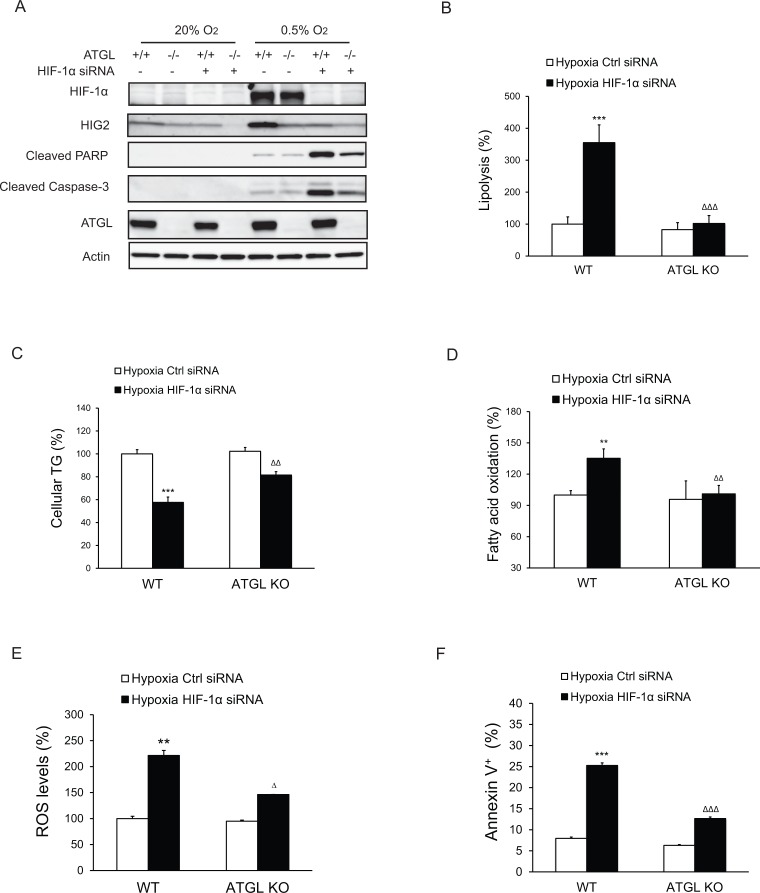
Apoptosis induced by HIF-1α knockdown is lipolysis-dependent.HCT116 WT or ATGL KO clone cells were transfected with control siRNA or HIF-1α specific siRNA for 24 hr, followed by incubation under normoxia or hypoxia for indicated times. (A) Cell apoptosis was detected by immunoblotting after 48 hr of incubation under normoxia or hypoxia. (B, C) Lipolysis (B) or TG contents (C) in cells after 24 hr of incubation under hypoxia. (D, E) FAO (D) or ROS levels (E) in cells after 36 hr of incubation under hypoxia. (F) Cell apoptosis was detected by Flow Cytometry after 48 hr of incubation under hypoxia. All data represent three independent experiments. n = 6 biologically independent experiments for (B); n = 4 biologically independent experiments for (C); n = 4 biologically independent experiments for (D); n = 3 biologically independent experiments for (E); n = 3 biologically independent experiments for (F). **p<0.01, ***p<0.001 vs. WT Hypoxia Ctrl siRNA; ∆∆p<0.01, ∆∆∆p<0.001 vs. WT Hypoxia HIF1α siRNA. Graphs represent mean ± SD, and were compared by two-tailed unpaired Student t-test.